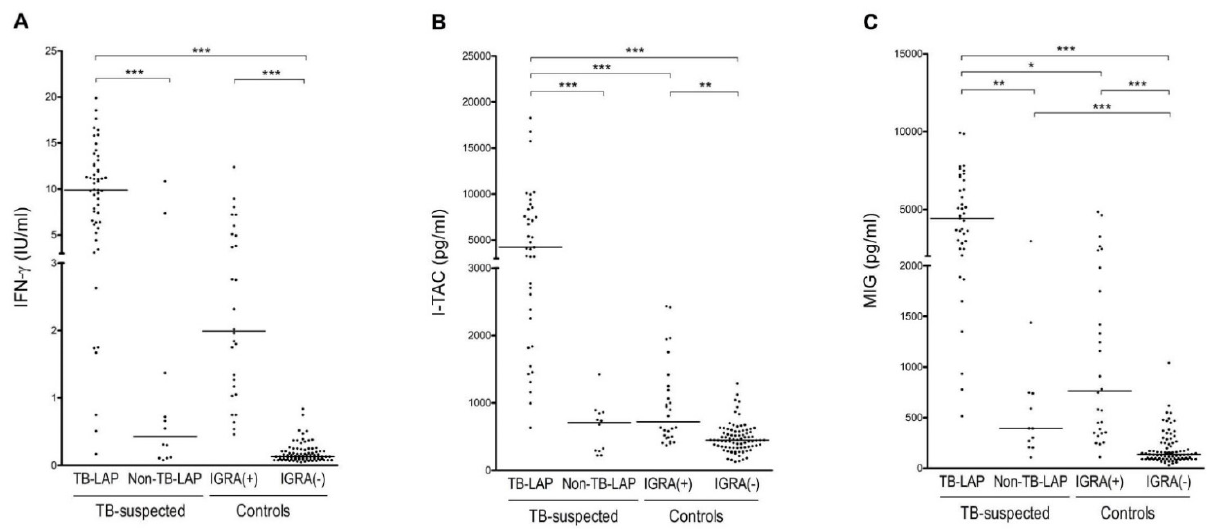
Table 4. Diagnostic performance of markers for differentiation of TB-LAP patients ( n = 53) from those in other groups. AUC